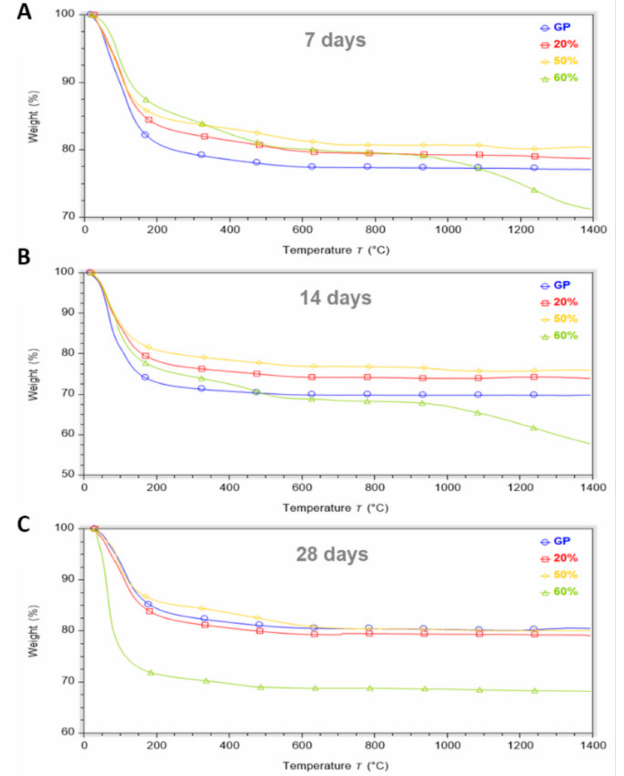
Figure 9. TGA of GP, GP/WG samples for 7 ( A ), 14 ( B ), 28 ( C ) days of curing